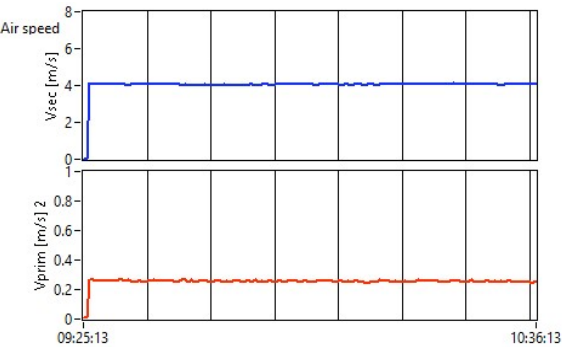
Figure 8. Evolution of primary and secondary air speed with a ratio of 1/4 and a flow rate of 19/56 L/min, during the test.